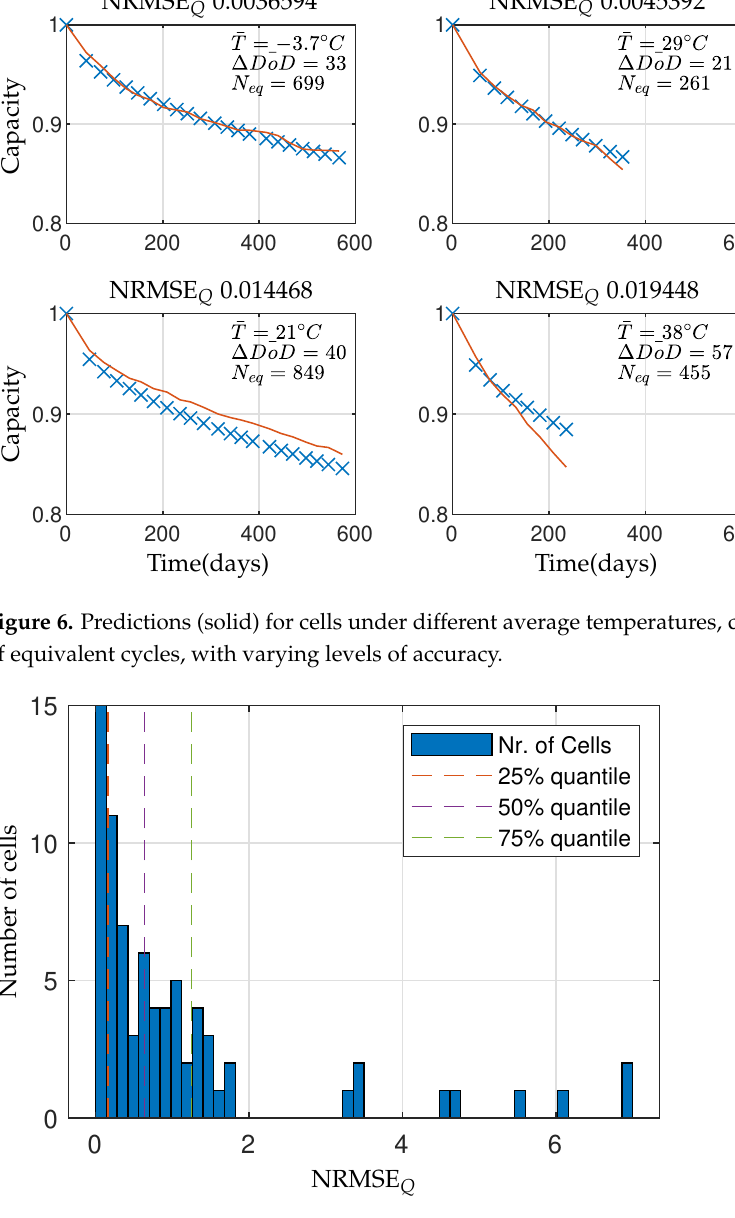
Figure 7. Histogram of the validation performance showing good validation for most cells and some unexplained ageing. unexplained